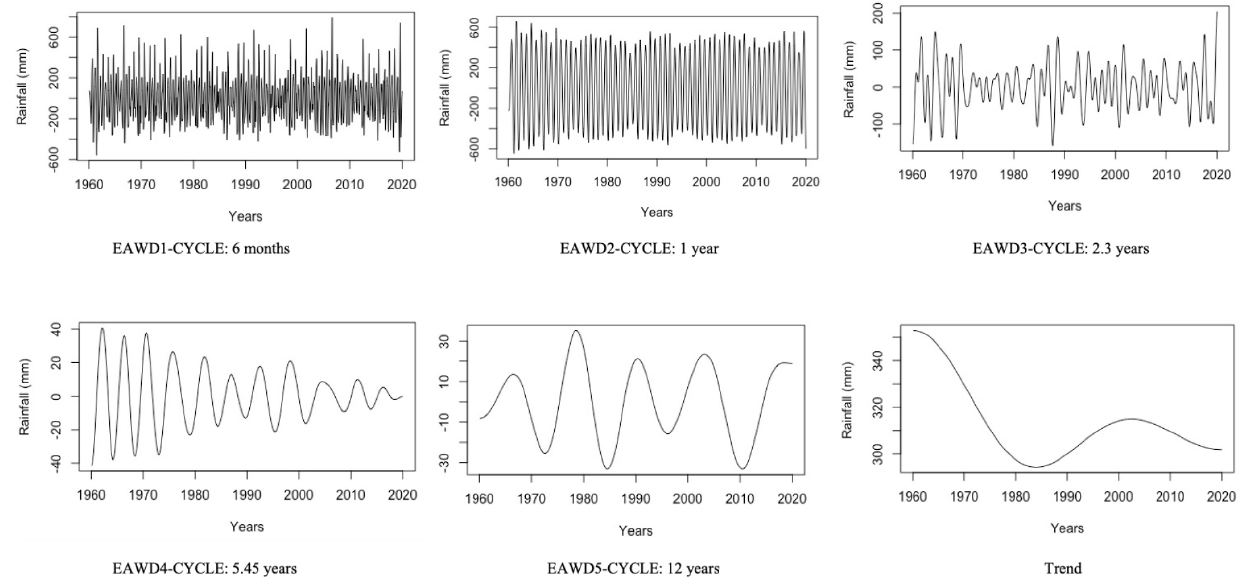
Figure 16. Rainfall time series EAWD decomposition results.